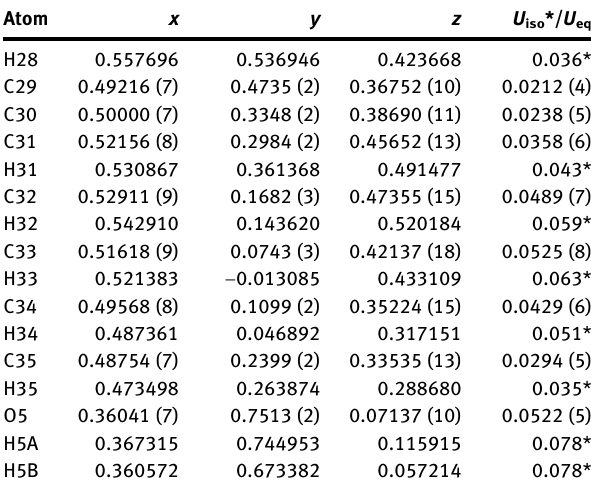
Table  : Fractional atomic coordinates and isotropic or equivalent isotropic displacement parameters (Å 